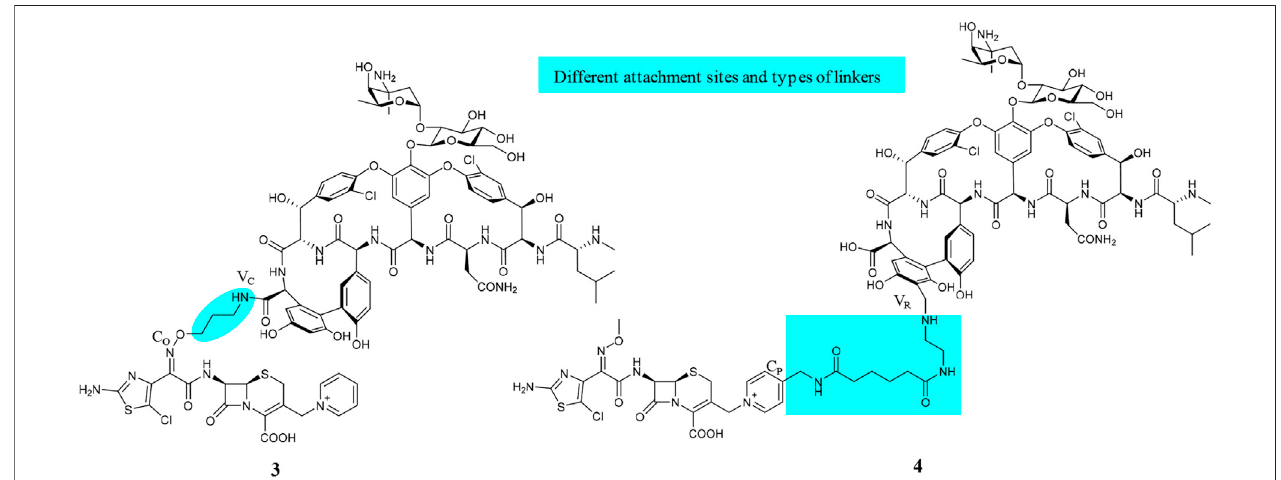
FIGURE 2 | Chemical structures of VAN hybrids, ce fi lavancin ( 3 , TD-1792), and TD-1607 ( 4 ).